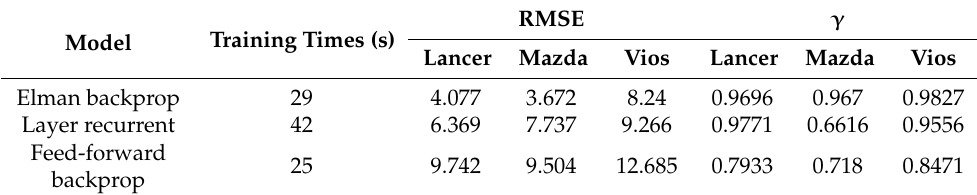
Table 4. Comparison of fuel consumption predictions of the three models. Training Times Model